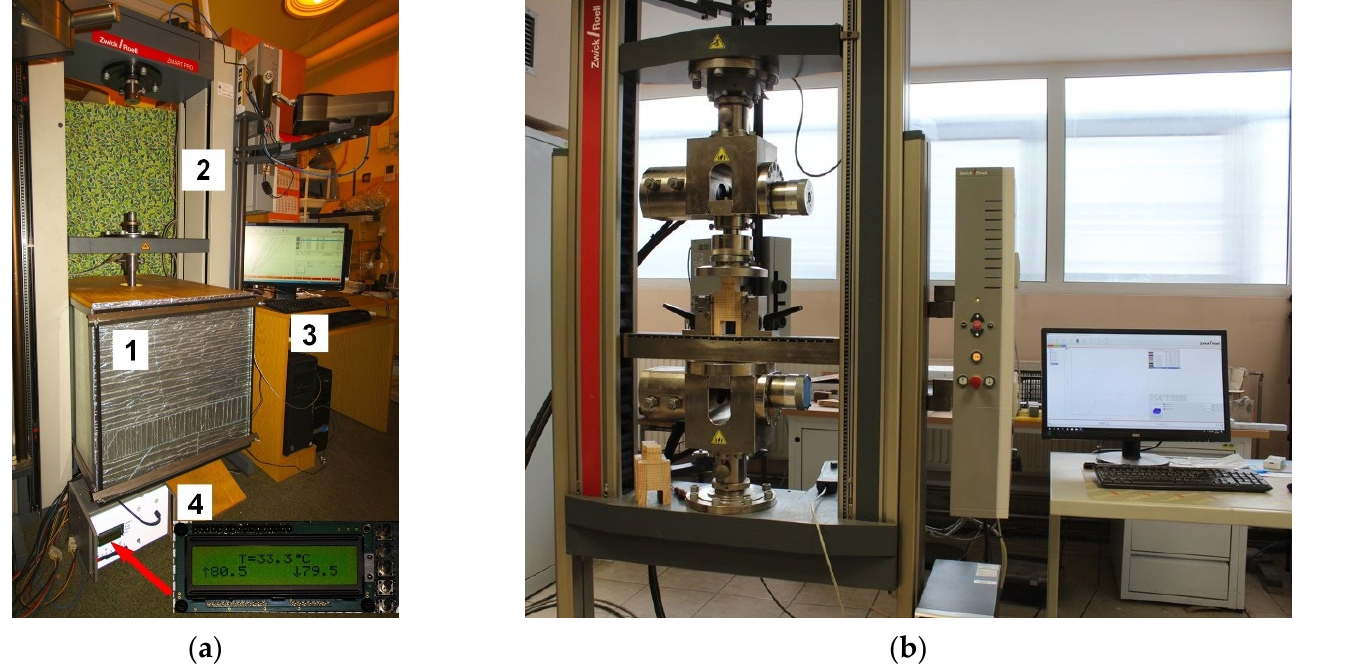
Figure 4. Test configuration details: ( a ) Zwick 1455 test stand: 1—temperature chamber, 2—strength tester, 3—control computer, 4—temperature regulator with power supply; ( b ) Zwick 100 test stand.